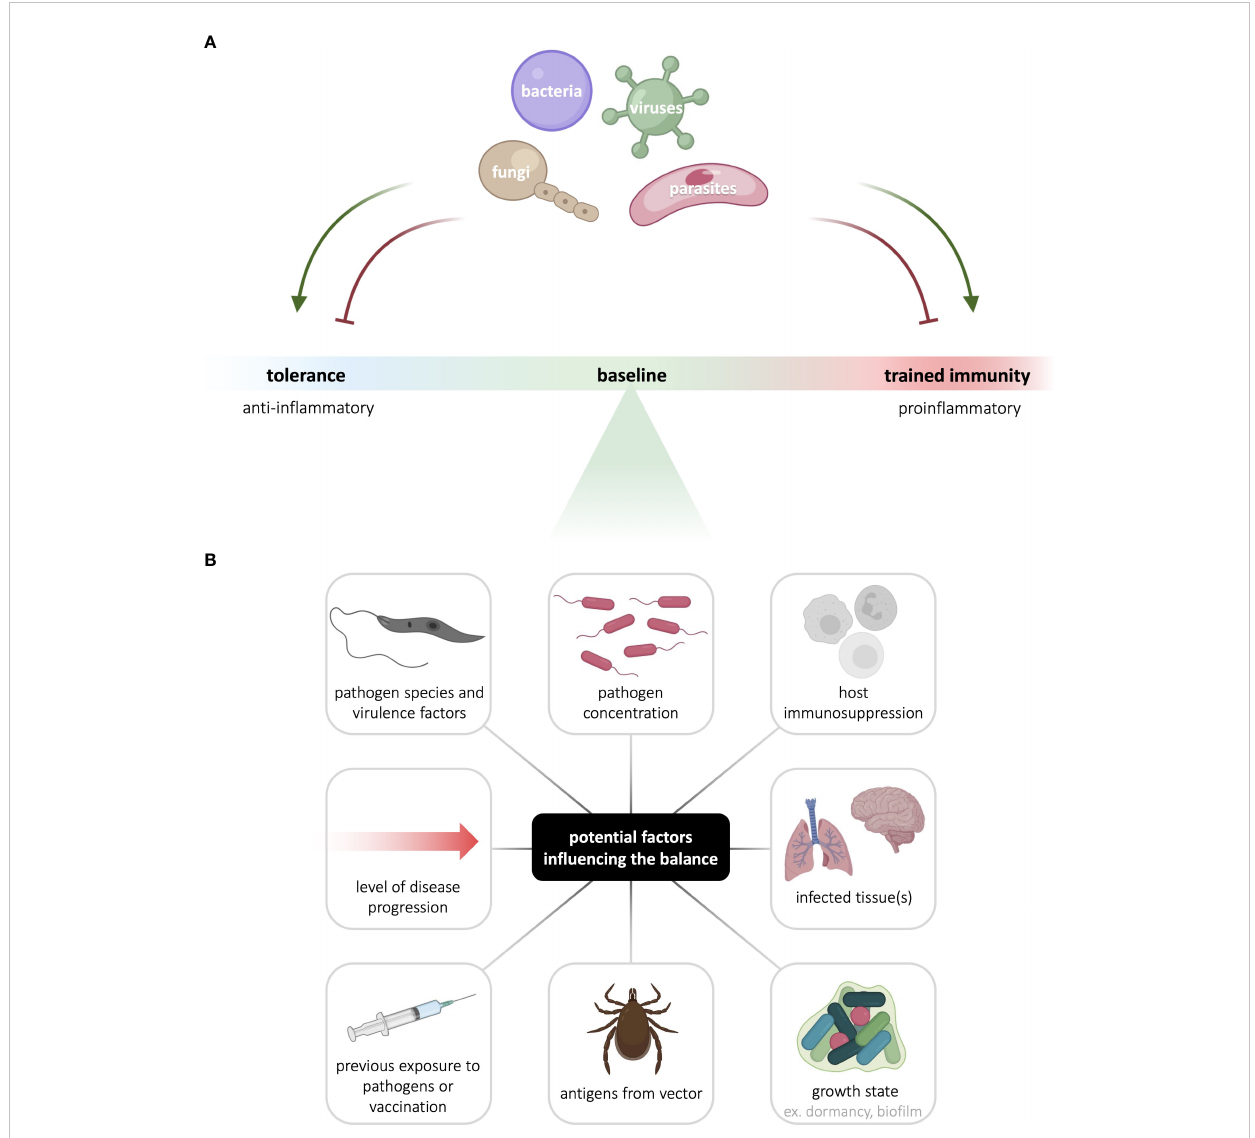
FIGURE 2 Innate immunological memory to infectious agents is context- and pathogen-dependent. (A) The nature and intensity of innate immunological memory mounted by myeloid and innate lymphoid cells varies with different pathogens. In addition, to enhance their survival and persistence, pathogens can hijack host cell signaling to skew innate immunological memory either towards or away from the canonically anti-in fl ammatory tolerance response or the canonically pro-in fl ammatory trained immune response. (B) Many factors can potentially contribute to the balance between tolerance and trained immunity, including factors linked to the pathogen, host, vector, and disease context. See the fi gure for examples of such factors. Figure made in part using BioRender (paid